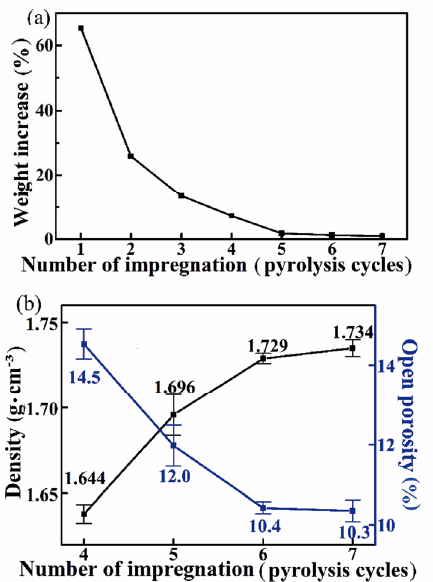
Fig. 7 (a) Weight increase and (b) density and open porosity of C f /SiBCN composites as a function of the number of PIP